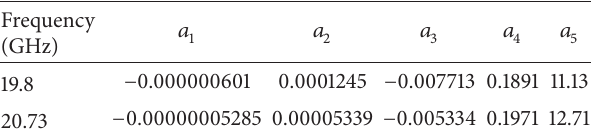
Table 6: Regression